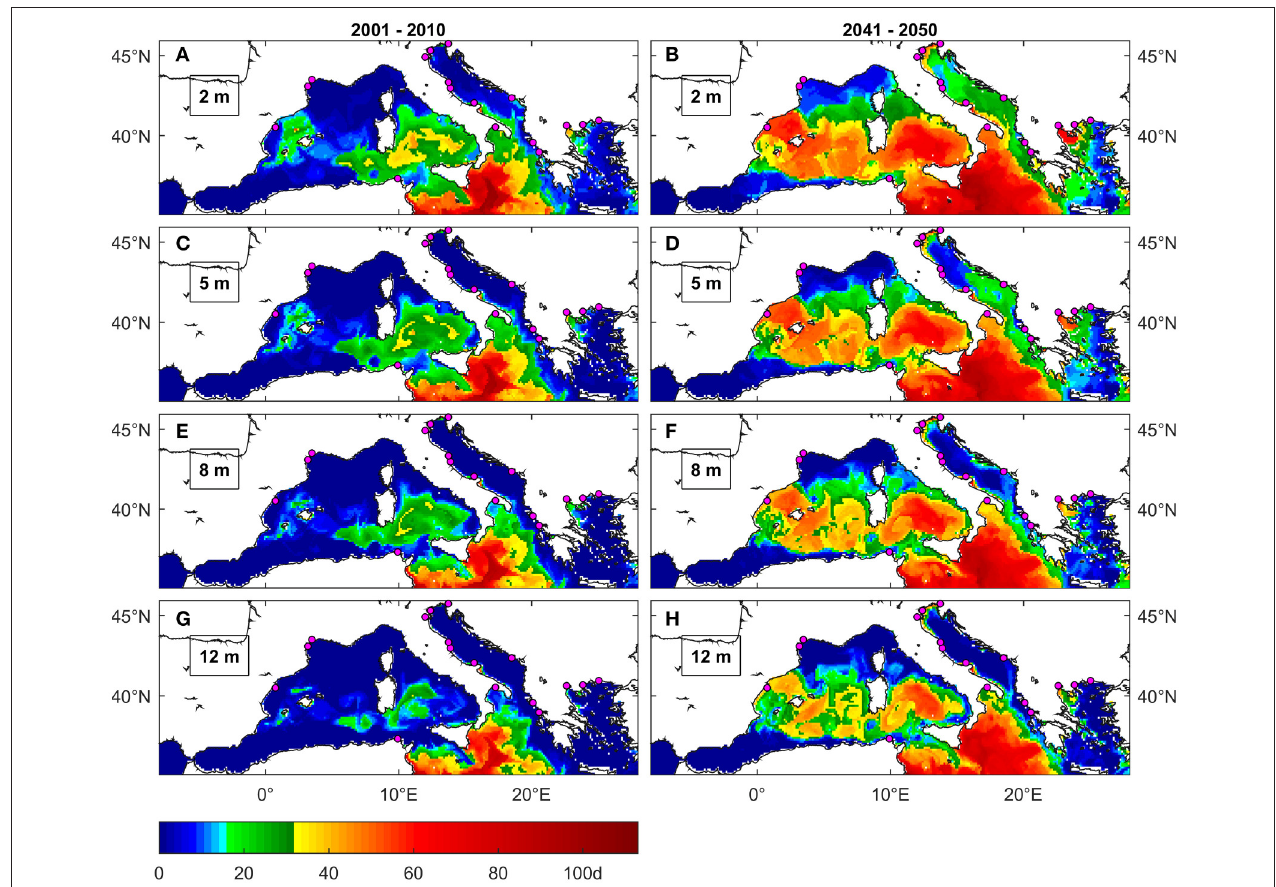
FIGURE 6 | Maximal number of consecutive days above 28 ◦ C under present (A,C,E,G) and future (B,D,F,H) conditions at different depths. The colormap is modified to highlight the thresholds of 15 (shades of green) and 30 days (yellow to red) that were reported respectively as lethal for mussels cultured in Spain ( Ramón et al., 2007) and partially lethal for mussels cultured in the Aegean (Anestis et al., 2007). Magenta dots are locations of mussel farming facilities (Rodrigues et al., 2015).